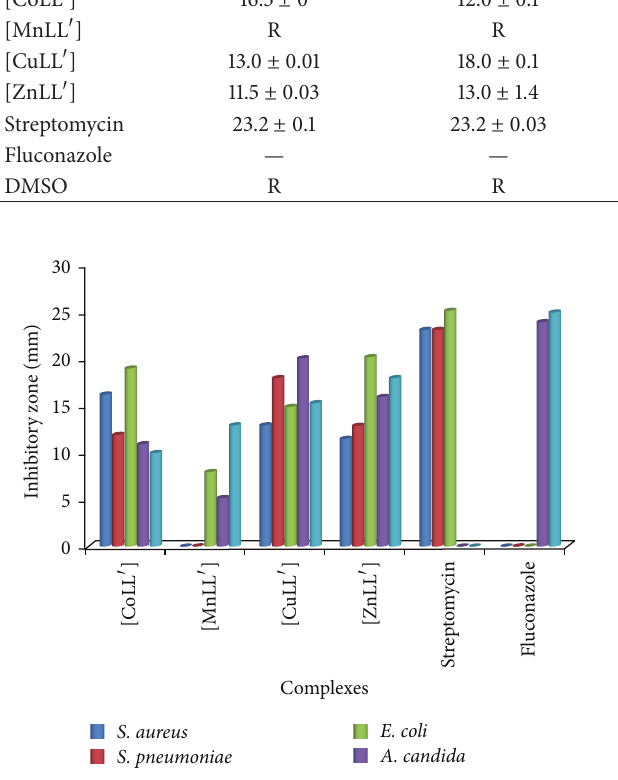
Figure 6: Histogram presentation of antimicrobial activity of the mixed ligand